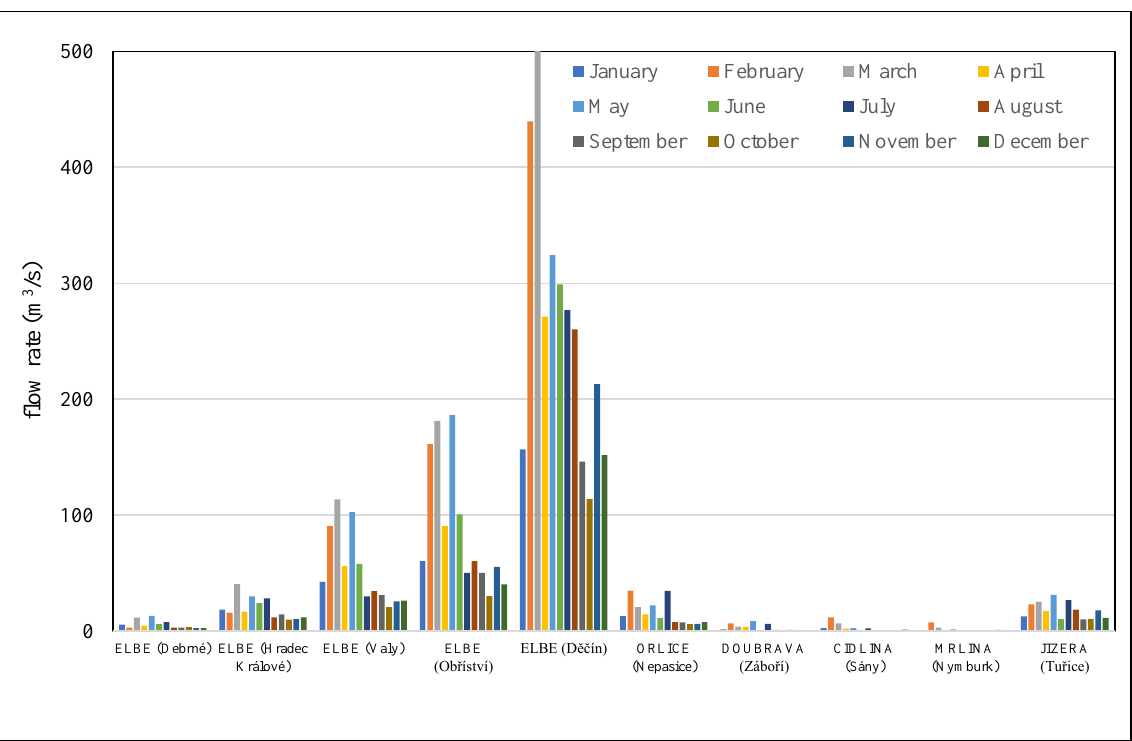
Figure 6. Residues of lamotrigine in surface water of the Elbe River basin.